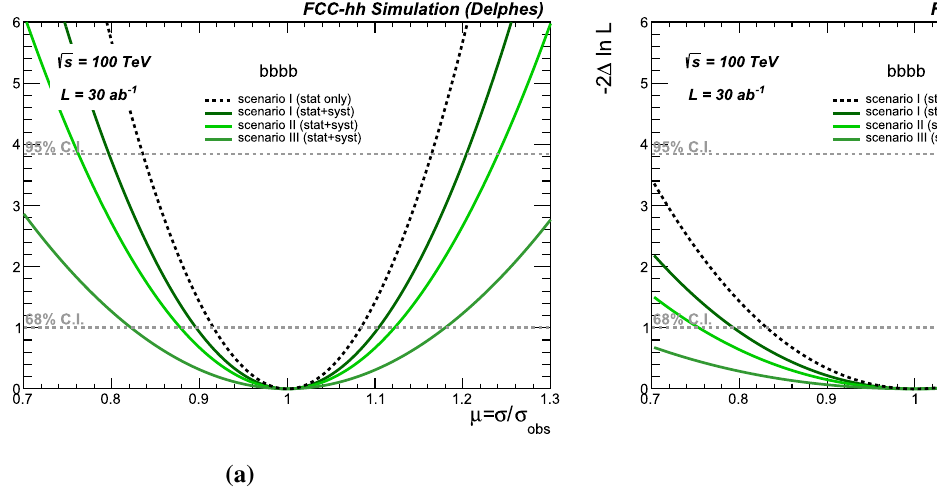
Fig. 12 Expected Negative log-Likelihood scan as a function the sig- nal strength μ = σ/σ SM ( a ) and trilear self-coupling modifier κ λ = λ /λ SM ( b ) in the b ¯ bb ¯ b channel. The various lines correspond to the 3 3